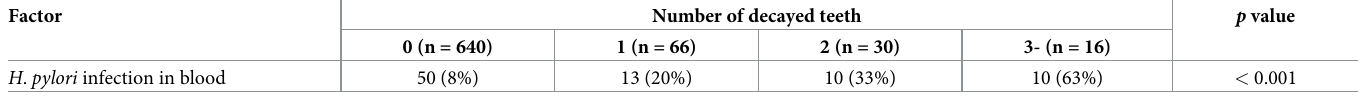
Table 4. Differences in the proportion of H . pylori infection in blood according to different number of decayed teeth. Factor